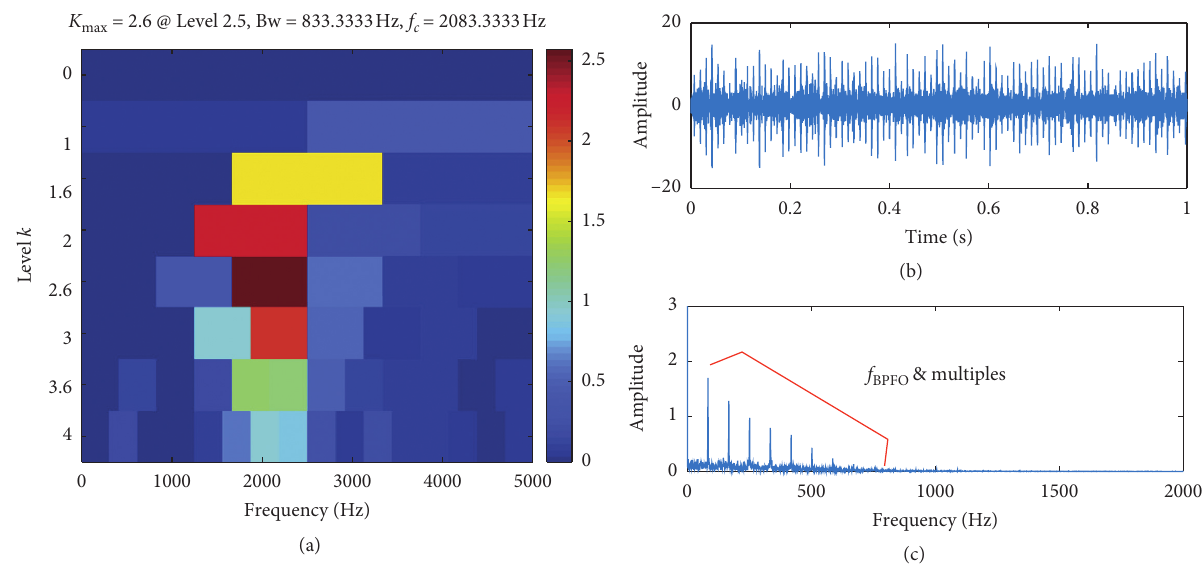
Figure 29: Spectral kurtosis for identification of wheelset bearing outer race fault. (a) Fast Kurtogram; (b) filtered signal; and (c) envelope spectrum of signal in Figure